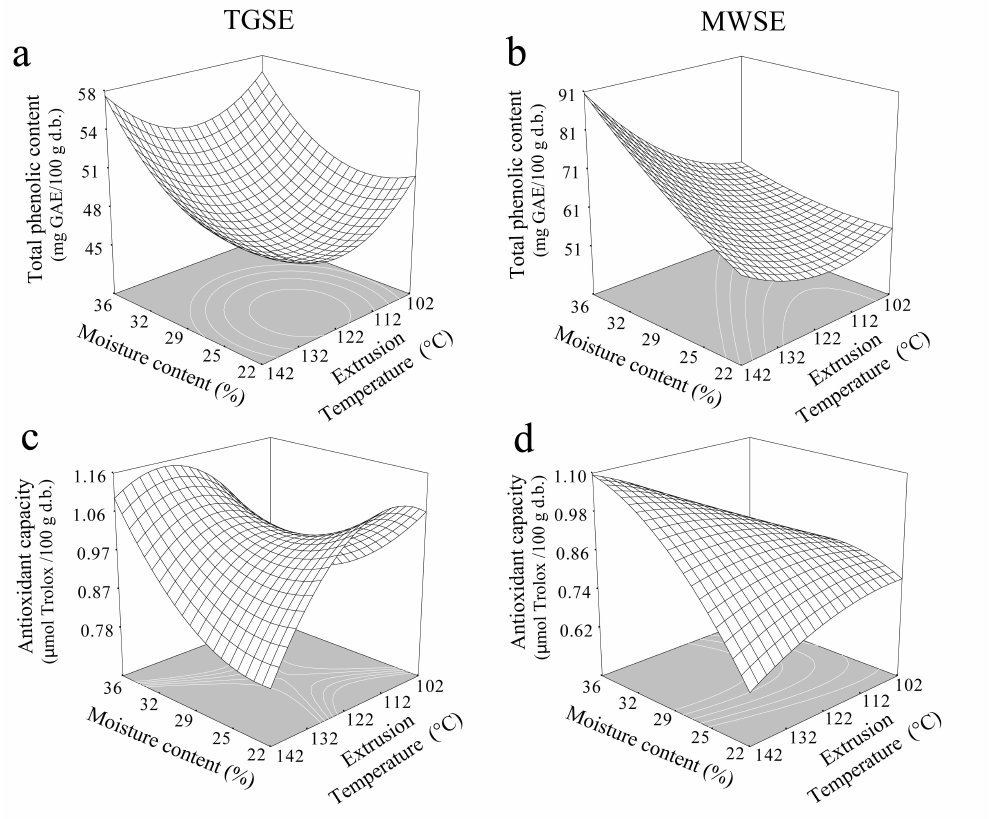
Figure 3. The effect of extrusion temperature and moisture content of total phenolic and antioxidant activity at a screw speed of 133 rpm: ( a ) Total phenolic content of TGSE, ( b ) Total phenolic content of MWSE, ( c ) Antioxidant activity of TGSE, and ( d ) antioxidant activity on